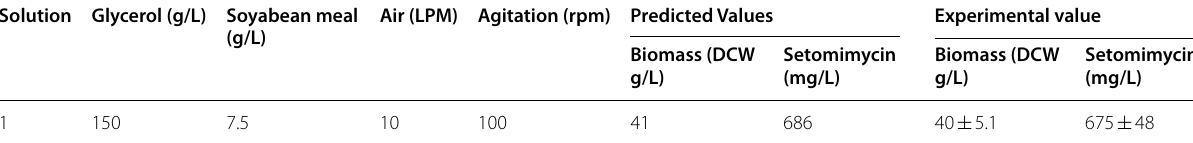
Table 9 Validation of Taguchi experimental data values for biomass (DCW) and setomimycin production by Streptomyces sp. RA-WS2 Solution Glycerol (g/L) Soyabean meal